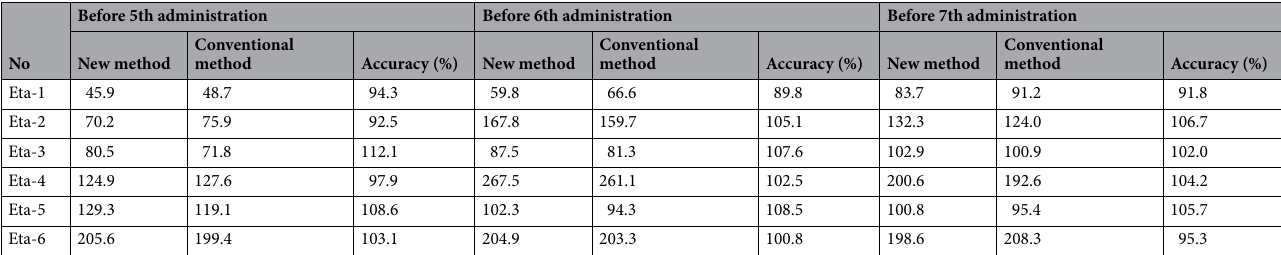
Table 6. The concentration of etanercept in patients with AS before the fifth, sixth, and seventh administration of 50 mg